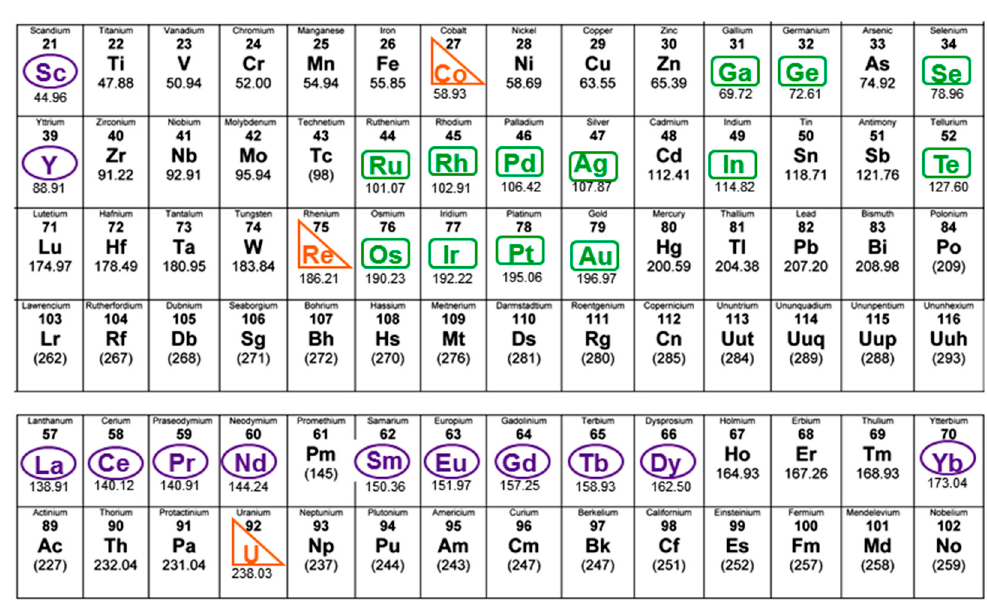
Figure 1. Periodic table indicating the critical and scarce metals taken into this study [1–3].